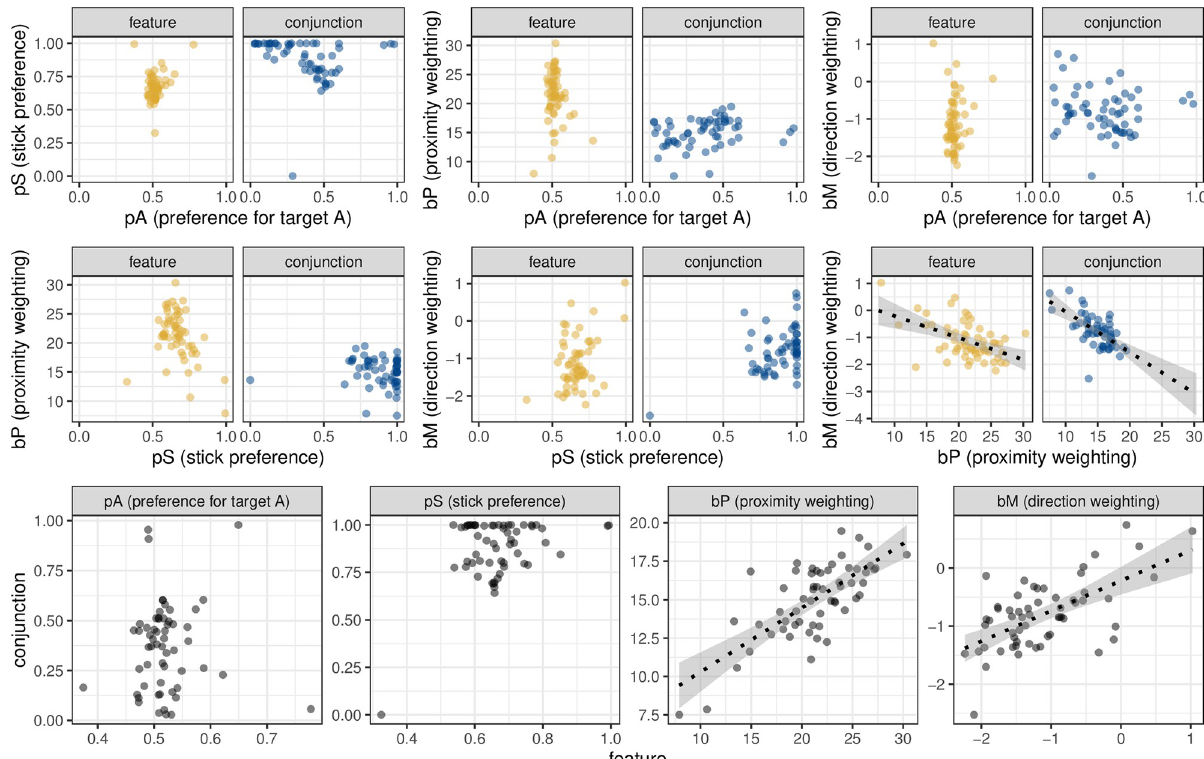
Fig 8. Individual differences in Clarke et al. (2018). The first two rows show the correlations in the random effect structure between different parameters. We can see that p and p appear to be independent from one another, and independent from the spatial biases b s s p m are correlated with one another in both the feature and conjunction conditions. The bottom row shows the correlation between conditions for each parameter in our model.